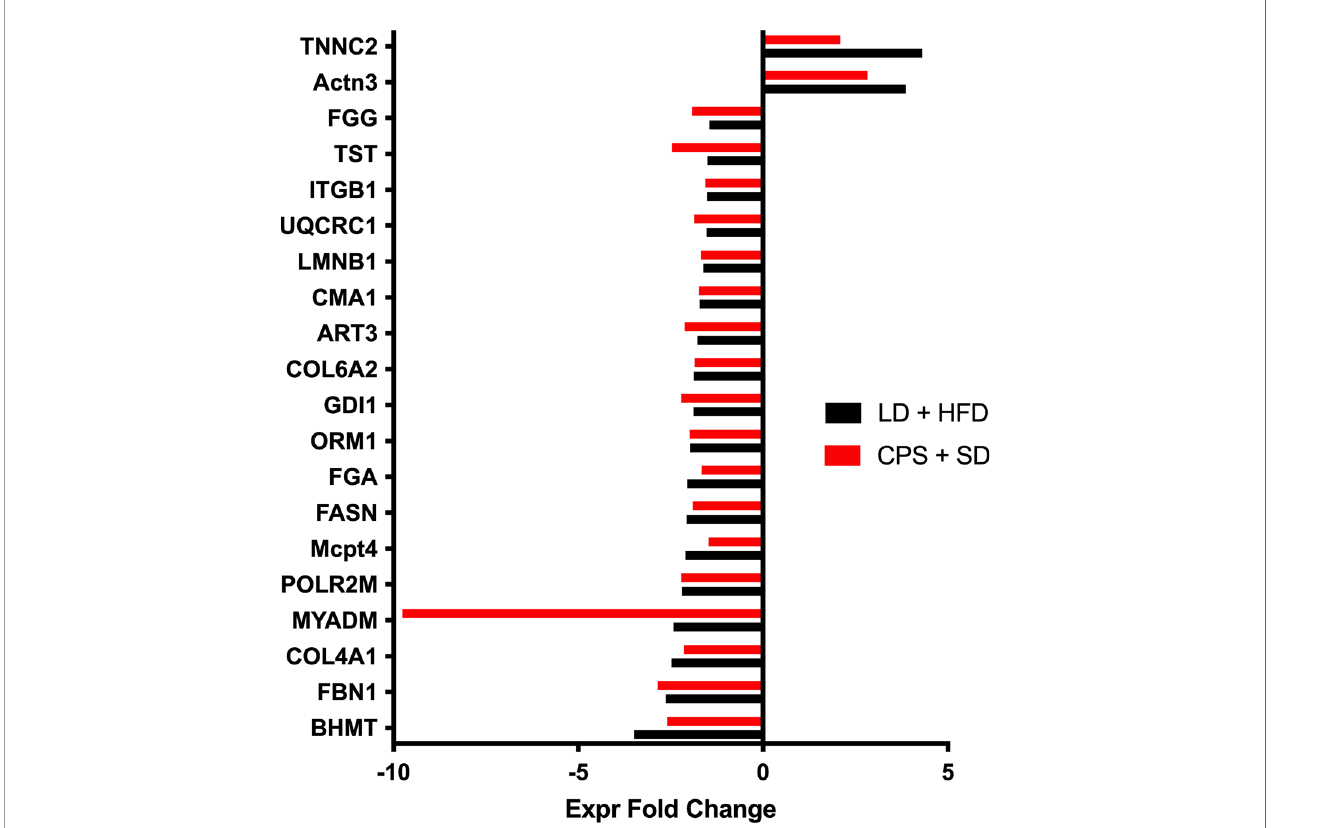
FIGURE 9 | Up and down expressed proteins in WAT from adult offspring gestated under control conditions and fed with high-fat diet during 12 weeks from postnatal day 100 onwards (LD + HFD group — black bar) and adult offspring gestated under CPS conditions and fed with standard diet postnatally (CPS + SD). Fold change in CPS + SD offspring is shown in red, and that of LD + HFD is in black. Data are expressed as mean of fold changes and were analyzed using Ingenuity Pathways Analysis